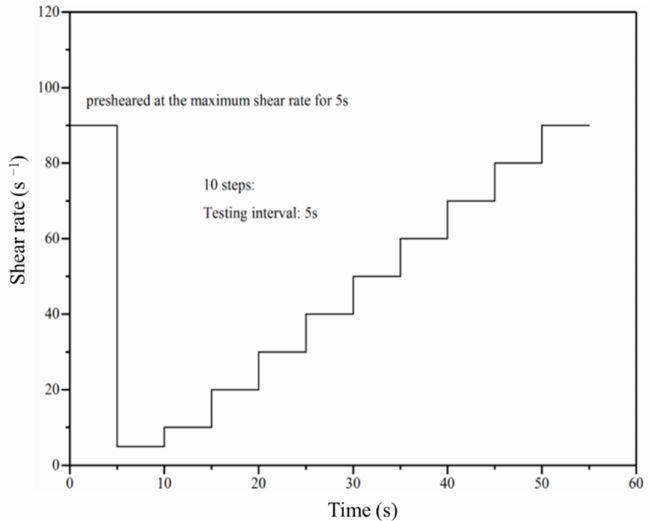
Figure 3. Rheological testing protocol of samples after mixing for 5